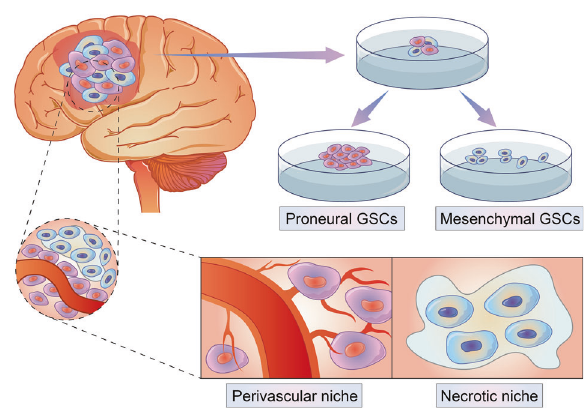
Fig. 2 Difference between PN GSCs and MES GSCs. They manifest different growth pattern of sphere culture in vitro. PN GSCs tend to form bigger sphere and show higher growth rate than MES GSCs in vitro. In vivo, PN GSCs locate at perivascular niche while MES GSCs prefer necrotic